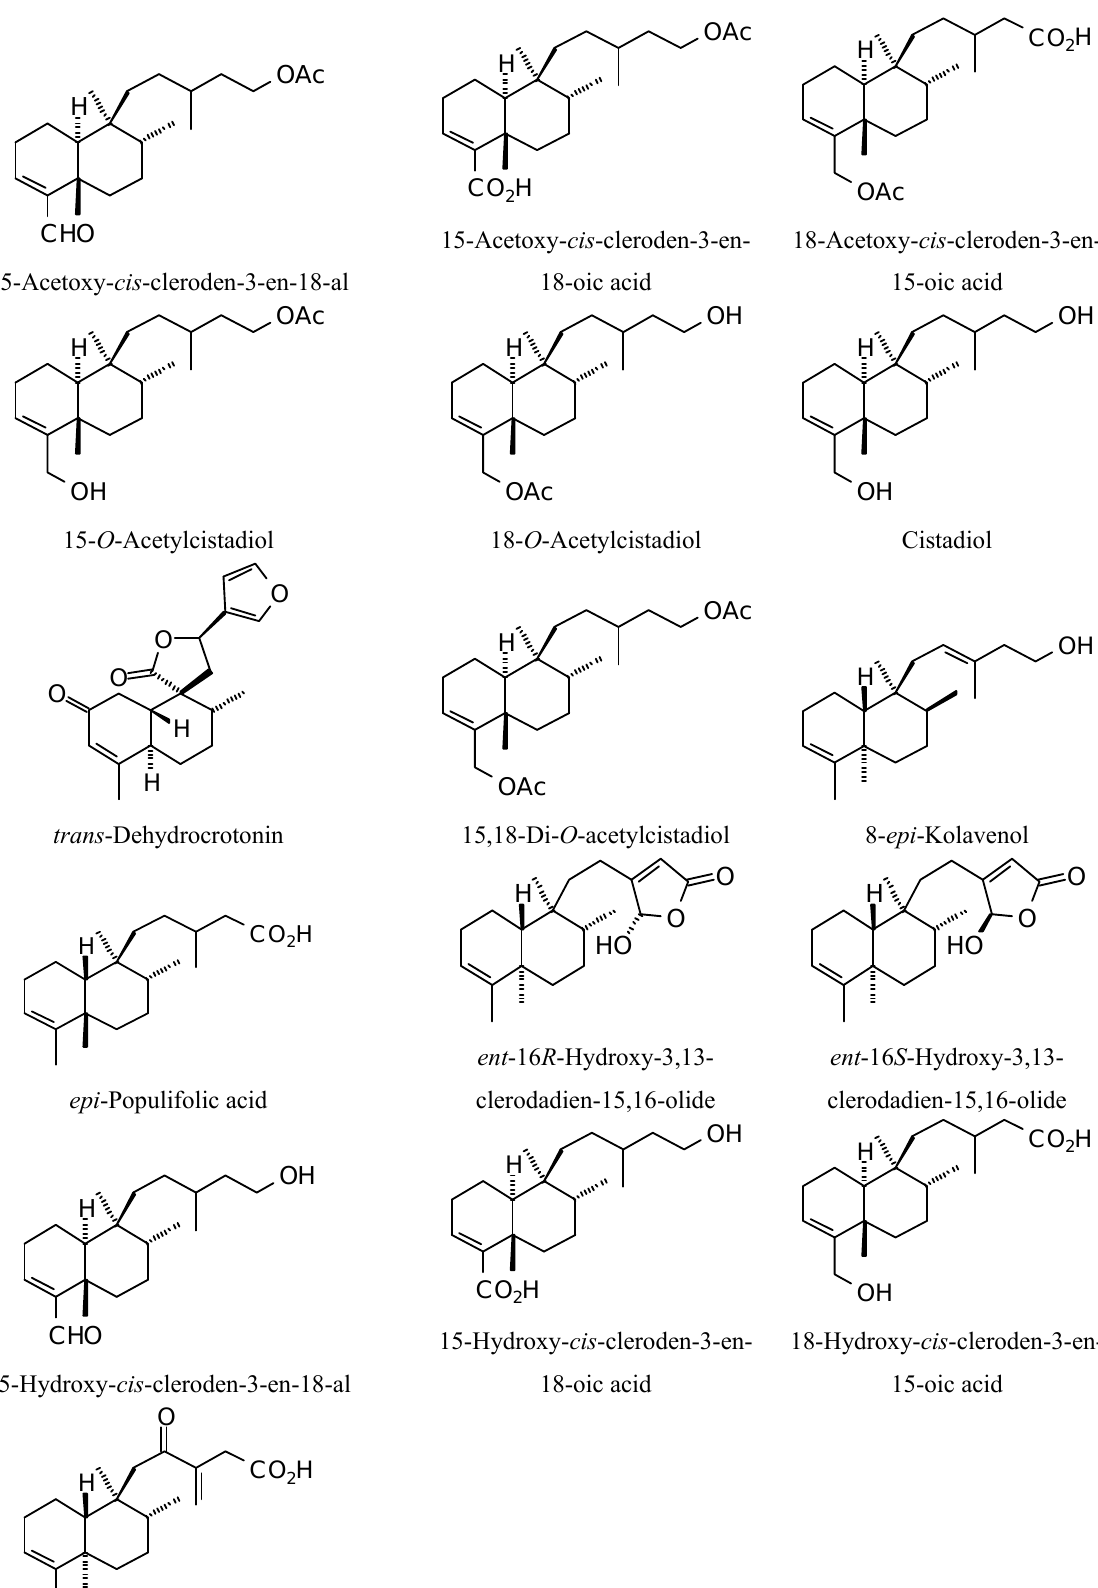
Figure 11. Clerodane diterpenoids examined in this